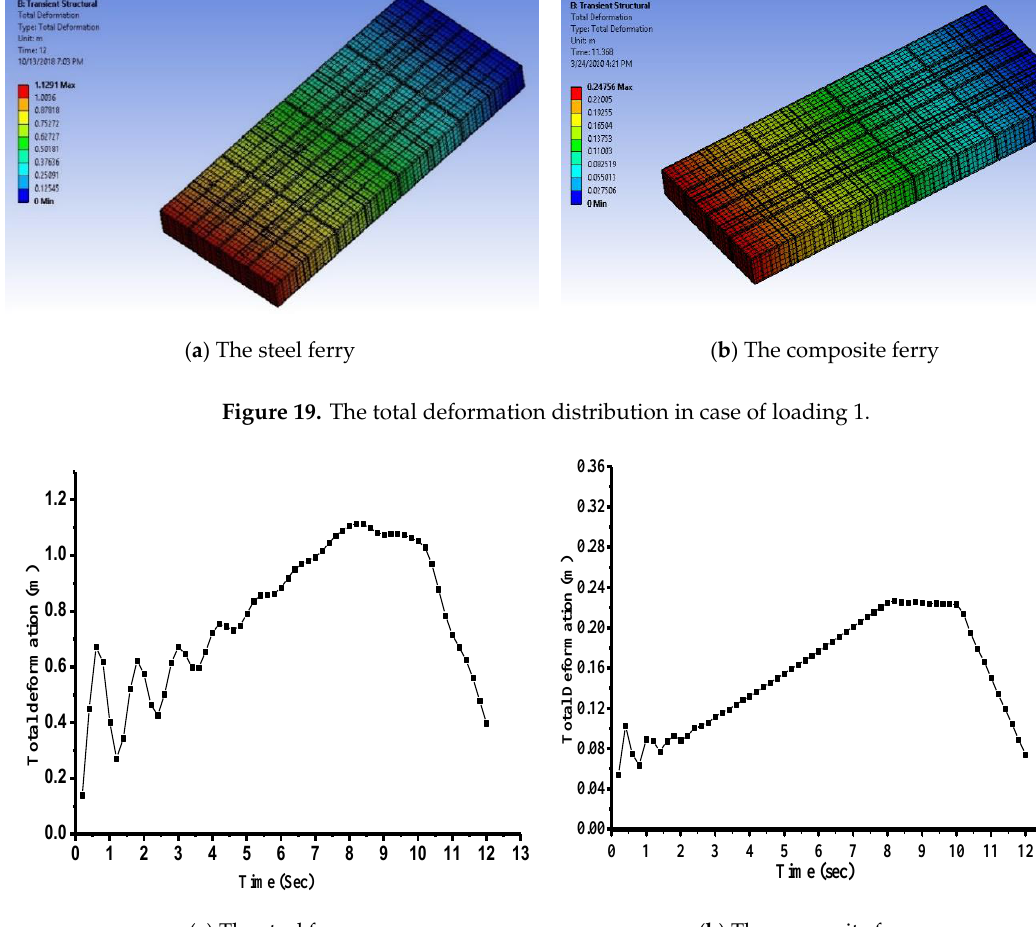
Figure 20. The maximum total deformations with time for case 1.